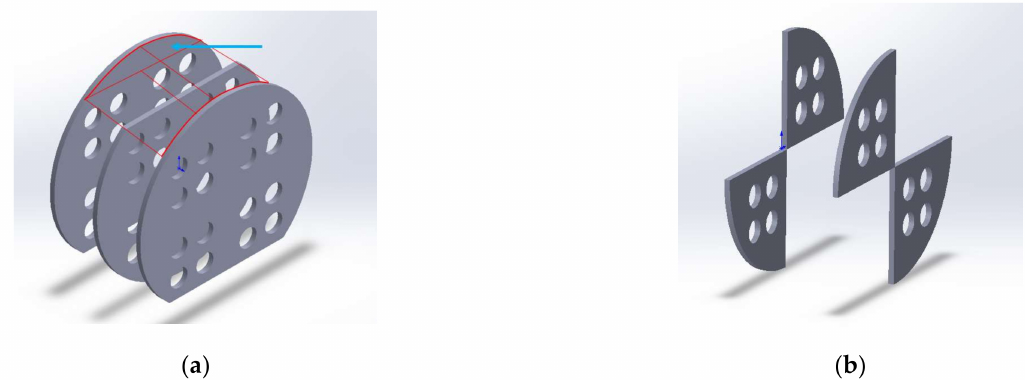
Figure 3. Single-curved baffle and flower baffle in shell and tube heat exchanger. ( a ) Single-curved baffle, ( b ) flower baffle.